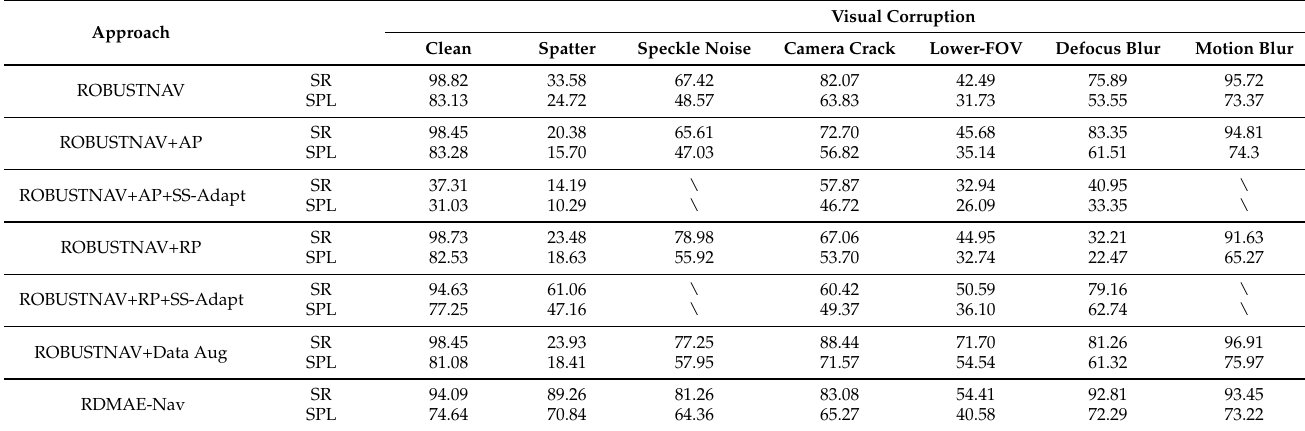
Table 1. Navigation performance comparison under clean and visual corruption. The comparative performance metrics here are SR and SPL, with higher SR and SPL reflecting the higher effectiveness and efficiency of the navigation method.